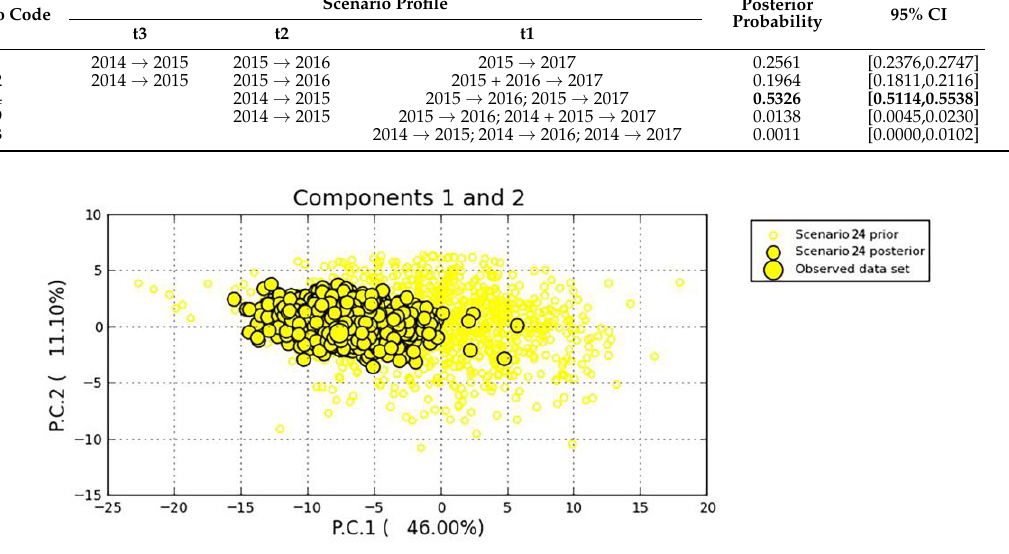
Figure 6. Goodness fit of Scenario 24 to the observed data evaluated in PCA analysis.